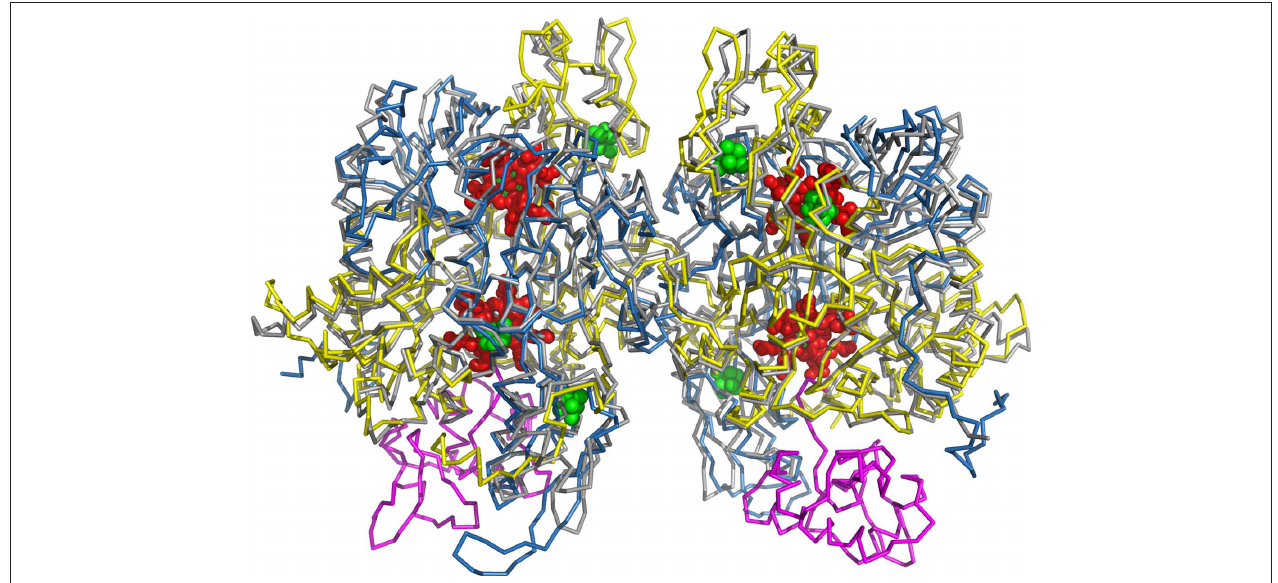
Figure 3 | C α superposition of D. norvegicum Drub (DrsA-yellow, DsrB-blue, and DsrC. magenta) and A. fulgidus dSir (gray), structures. For sake of clarity and due to high homology with Drub, the structures of D. vulgaris and D. gigas Dvirs were not represented. Sirohemes (red) and [4Fe–4S] clusters (green) are drawn in cpk